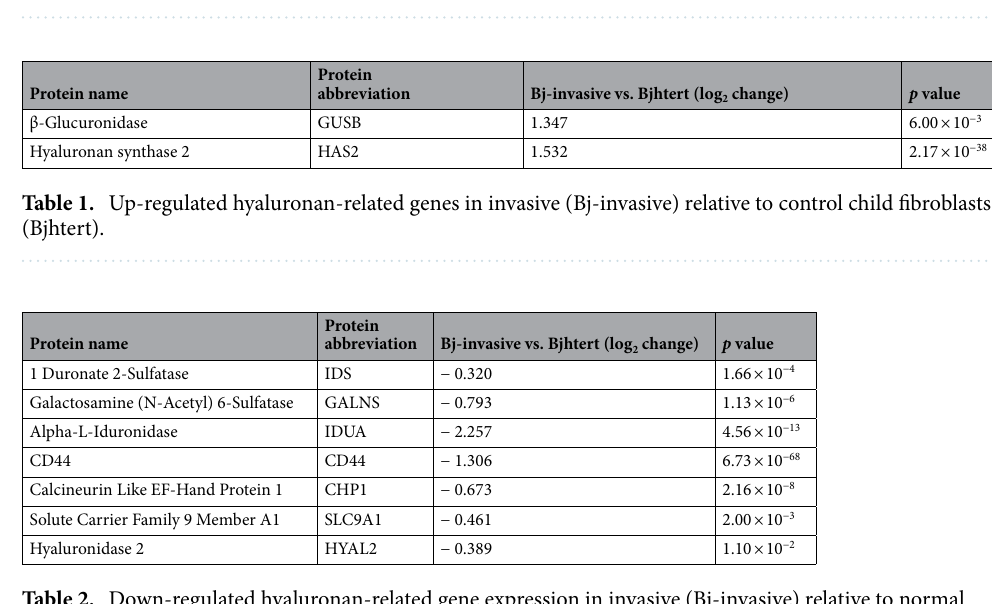
Figure 3. Hyaluronan distribution in Infantile fibrosarcoma. ( A ) Central (top), and peripheral (lower panel) areas of infantile fibrosarcoma, showing DAPI (left), hyaluronan (middle), and merged DAPI (blue) Hyaluronan (red) (right). Scale bar indicates 40 µm. ( B ) Hyaluronan levels at the peripheral (black) and central (grey) areas of infantile fibrosarcoma tumour sections. ** indicates p < 0.01.